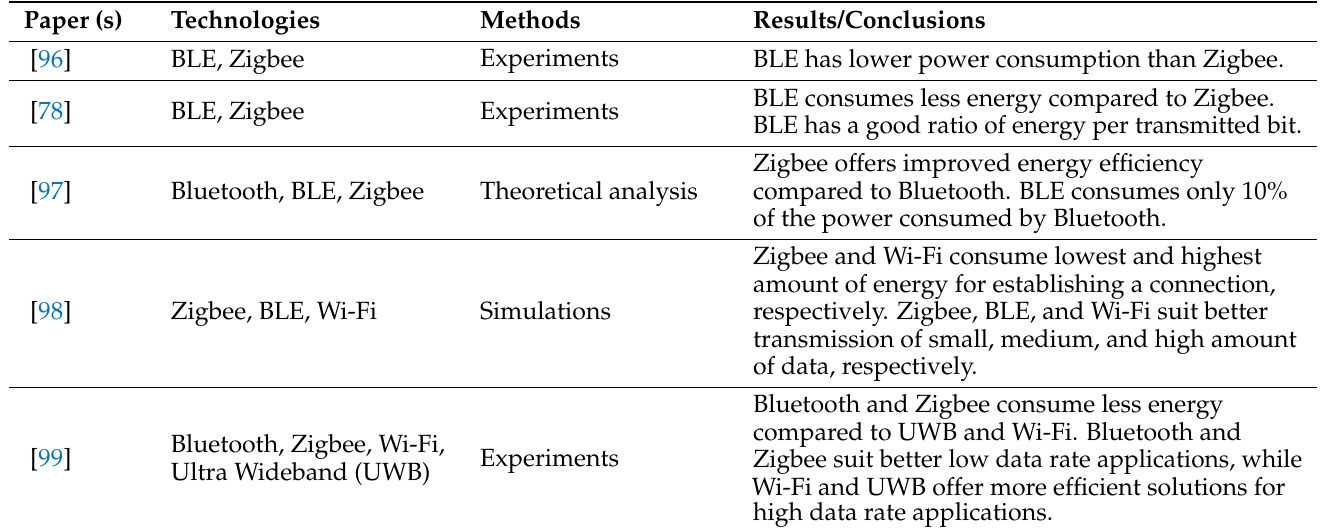
Table 3. Existing comparative analyses of LPSANs in terms of energy efficiency and consumption. Paper (s)